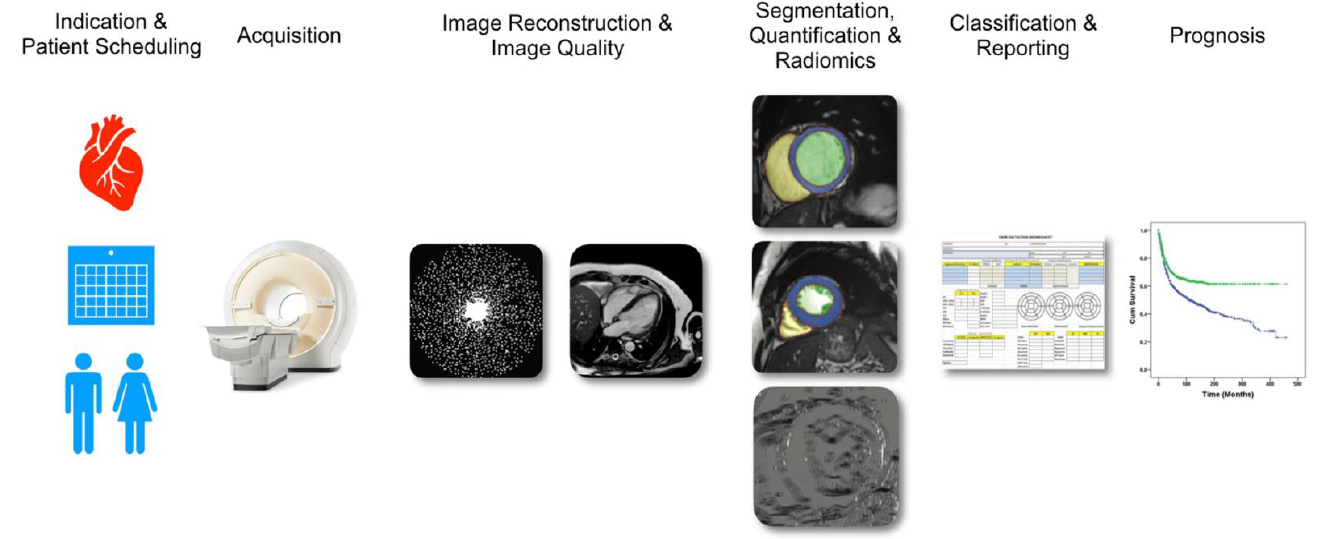
Figure 3. Aspects of cardiovascular magnetic resonance imaging that could be positively impacted by machine learning. These aspects range from patient scheduling to acquisition, image reconstruction, image segmentation, radiomic, classification and prognosis (adapted from Leiner et al. [70]).